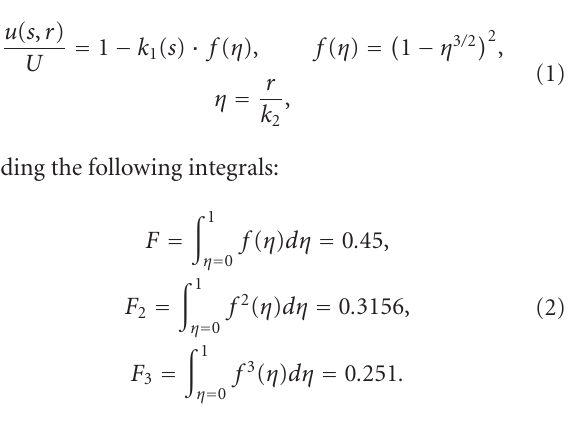
ment thickness δ 1 , momentum thickness δ 2 , and form factor H /δ = δ 12 1 2